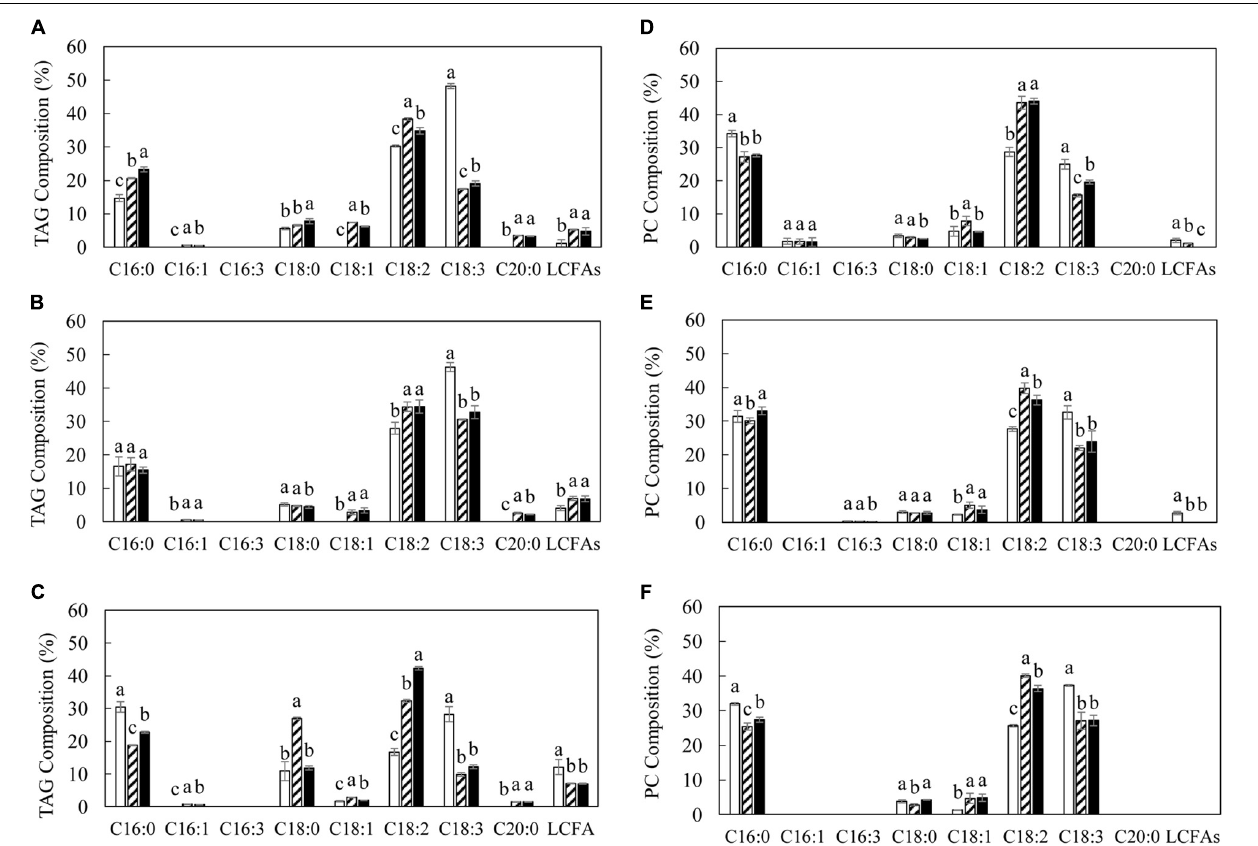
FIGURE 4 | Fatty acid compositions of TAG and PC in potato leaves at the three developmental stages in WT (open bar), L3 (bar with upward diagonal) and L5 (black bar). (A–C) TAG at the flowering, mature, senescent stages respectively; (D–F) PC at the flowering, mature, senescent stages respectively. The data represent the mean values ± SD of three biological replicates. Letters (a, b, c, and d) above the bars are based on LSD, bars marked with different letters are statistically significantly different at P <